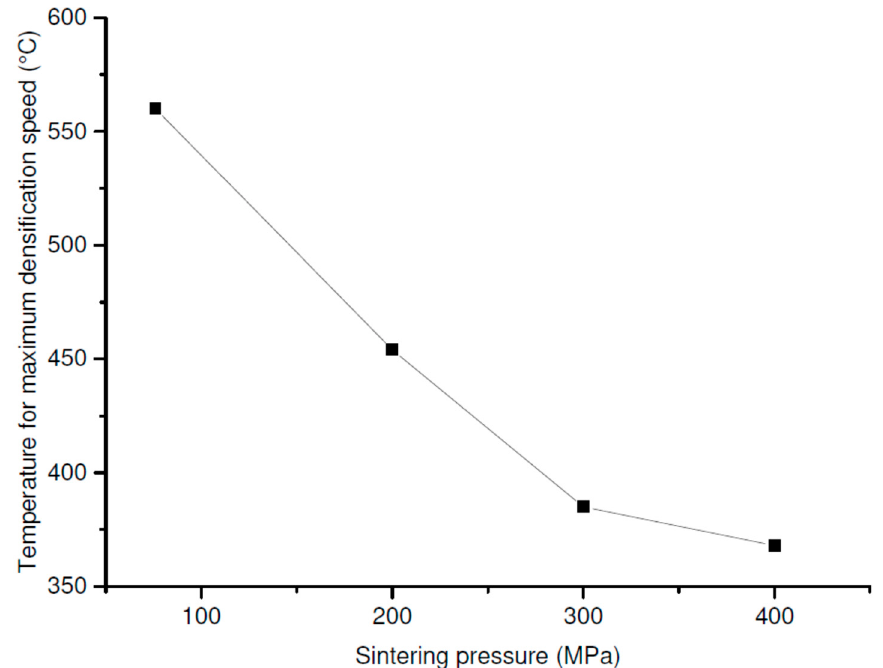
Figure 5. E ff ect of the pressure on the temperature showing the maximum densification Figure 5. Effect of the pressure on the temperature showing the maximum densification rate .